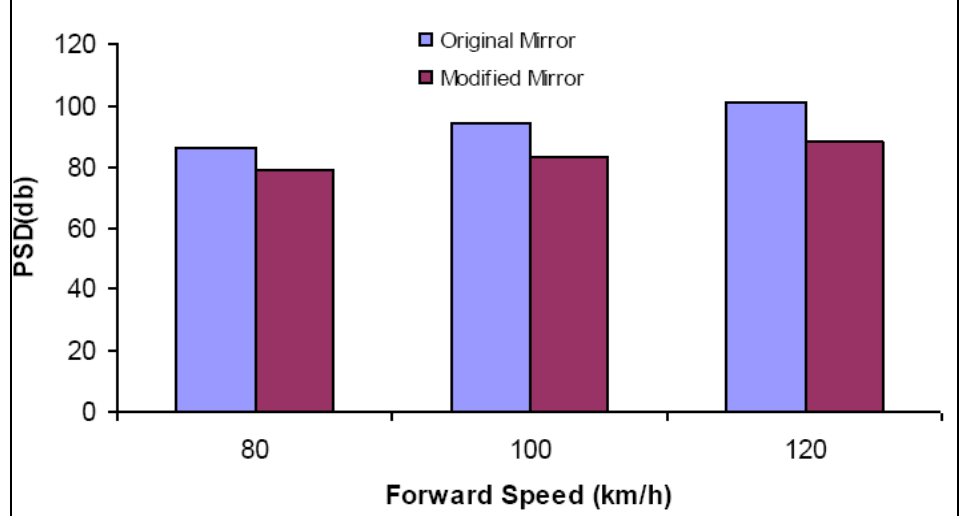
Figure 18. Comparison between oroginal and modiofied mirror in measured sound pressure